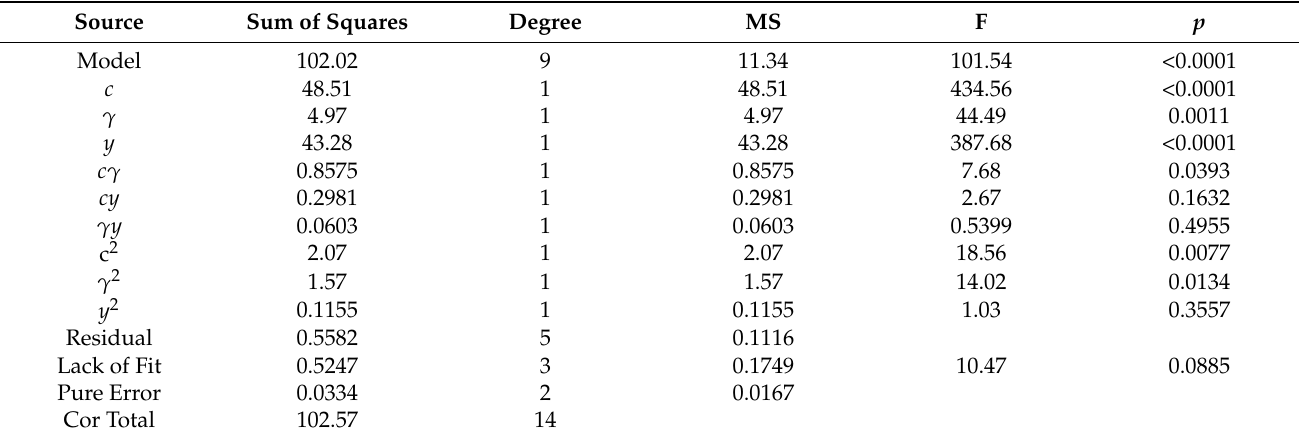
Table 9. Analysis of variance for fluid–soil coupling